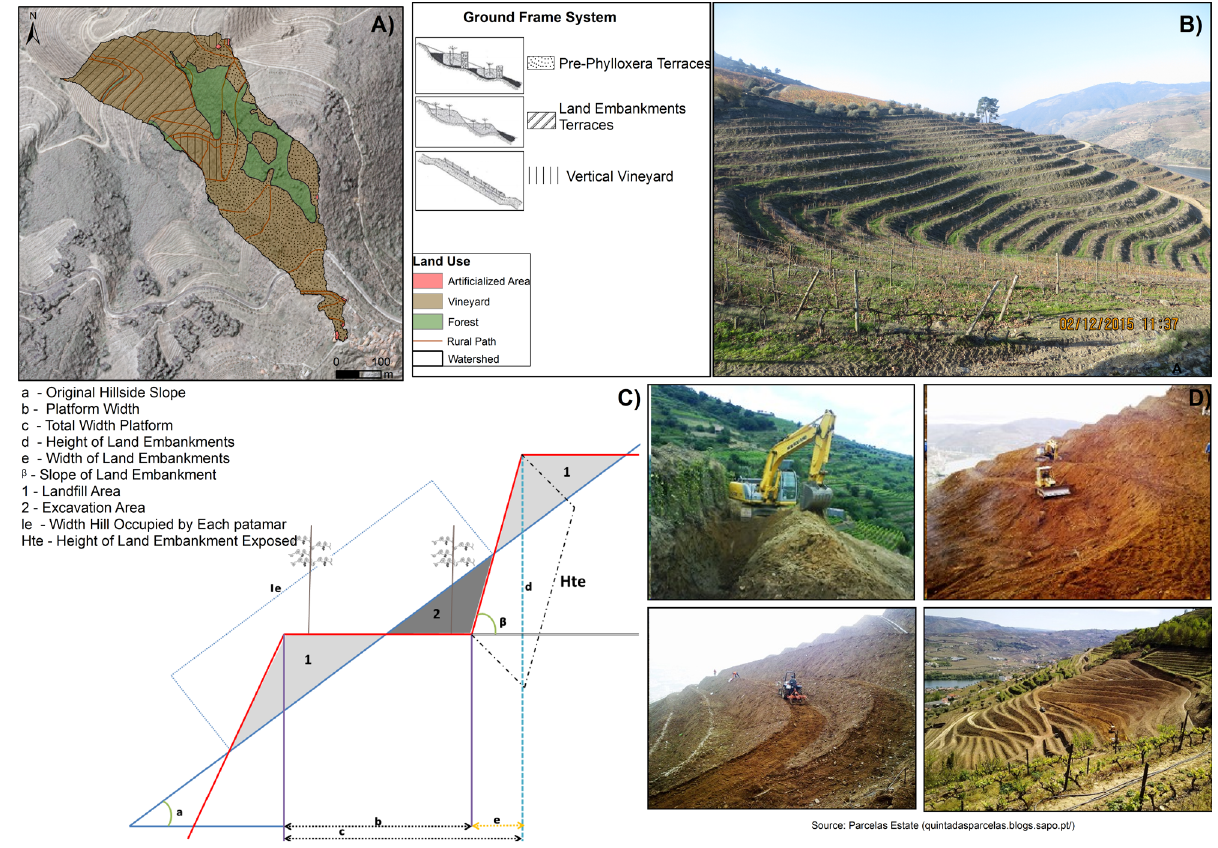
Figure 1: Agriculture Terraces at Douro valley. A - Ground frame system in S. Luis estate. B – Earthen embankment terraces. C – Terrace Geo- metry. D – Building process of the terrace platforms with earthen